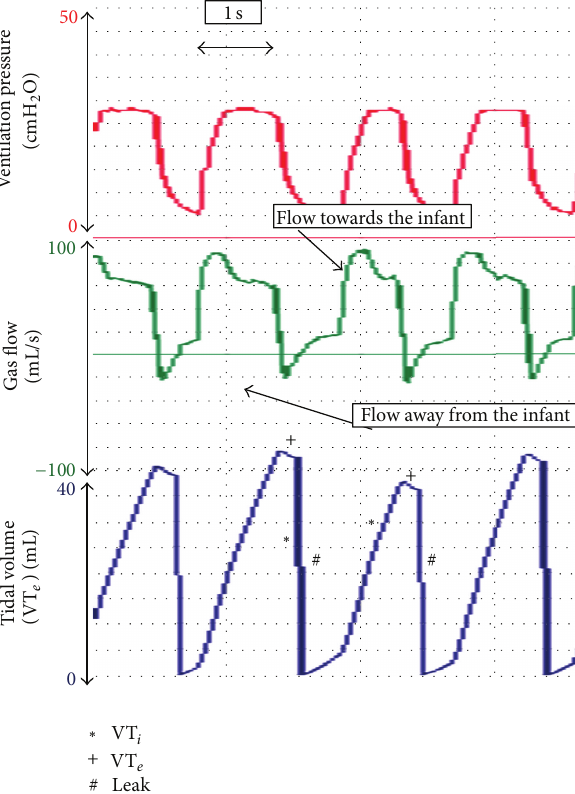
Figure 2: During PPV, the area underneath inspiratory gas flow is largercomparedtoexpiratorygasflow.Thisisreflectedinthedisplay of a large amount of leak around the